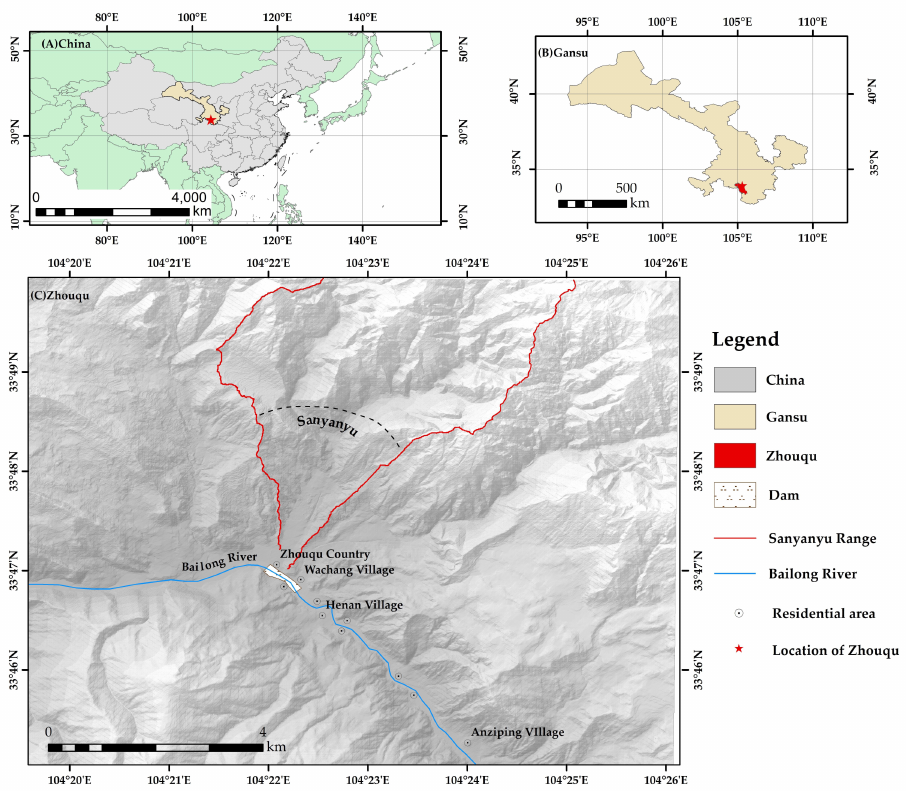
Figure 1. Location of the study area: ( A ) location of Gansu Province in China; ( B ) map of Gansu Province with the location of Zhouqu County; ( C ) topographic map of Zhouqu County.